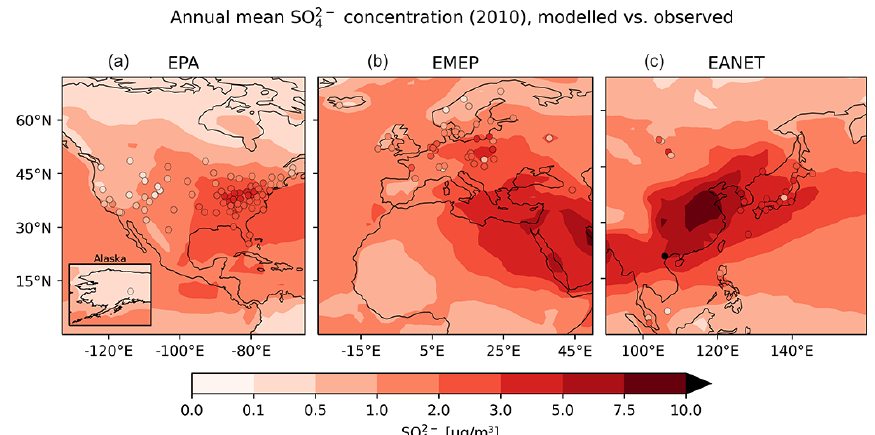
Figure 21. Annual mean SO 2 − concentrations for the year 2010 for the model and three observational networks: EPA, EMEP and EANET 4 (a–c) . Simulated data are shown as shaded contours, while the observational data are depicted as